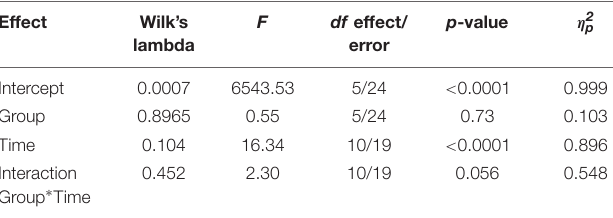
TABLE 1 | Full multivariate model of RM ANOVA with all variables covering the right side of the body.